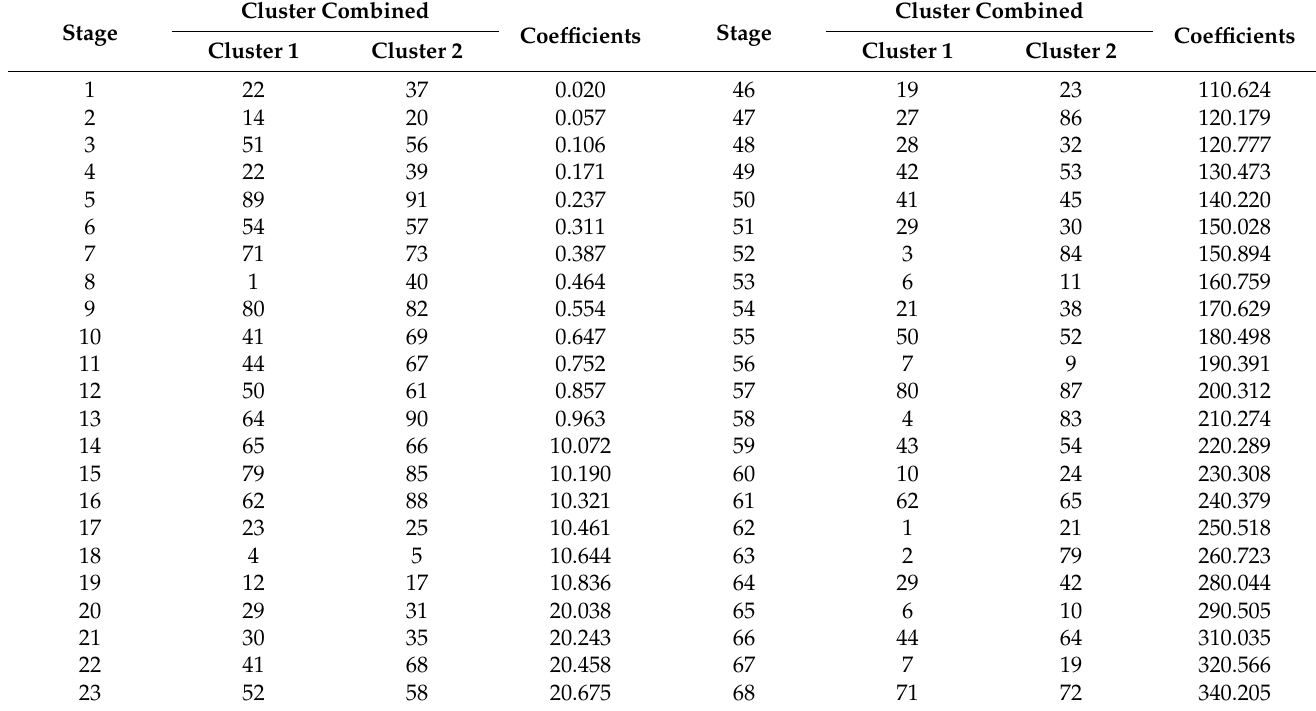
Table A1. Agglomeration coefficients for the hierarchical clustering (Ward with Euclidean